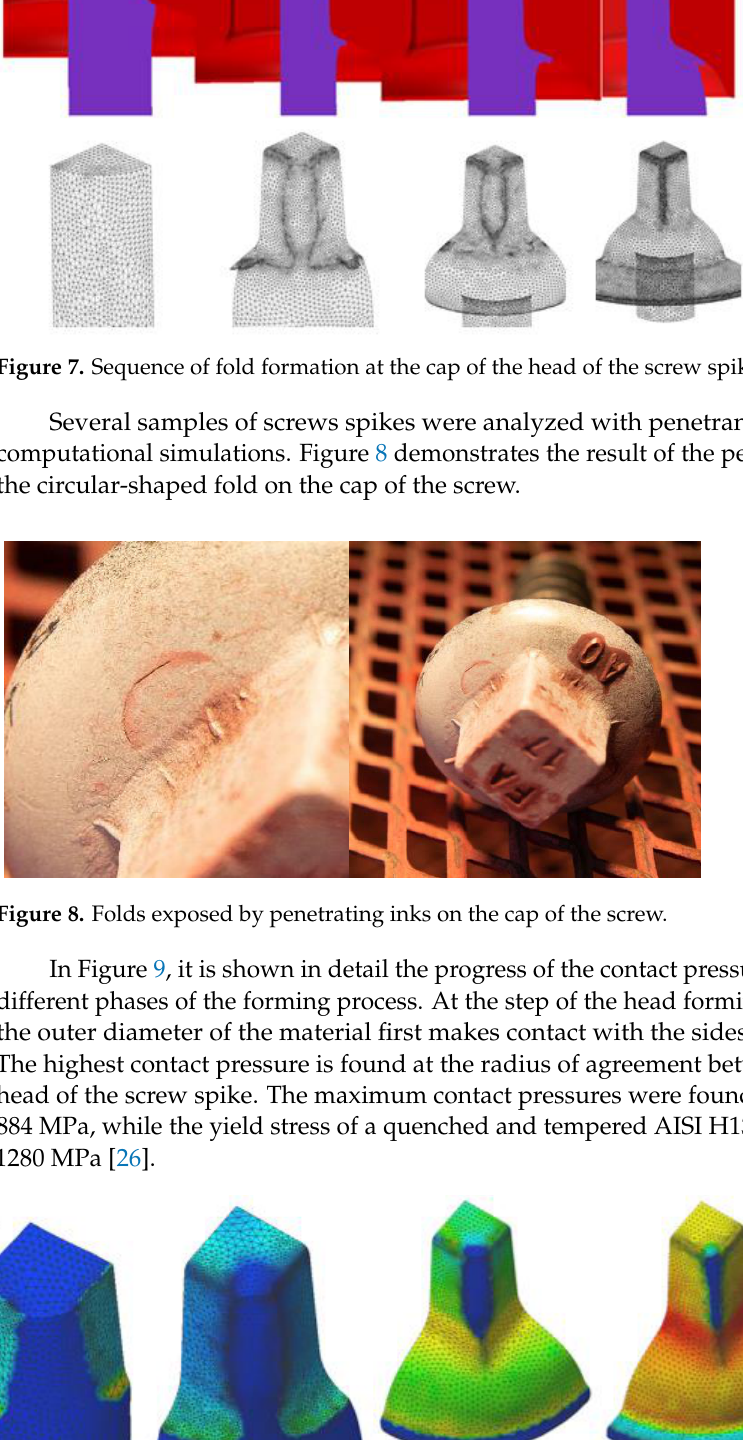
Figure 6. Influence order of the operating parameters on load and energy of the forming process.